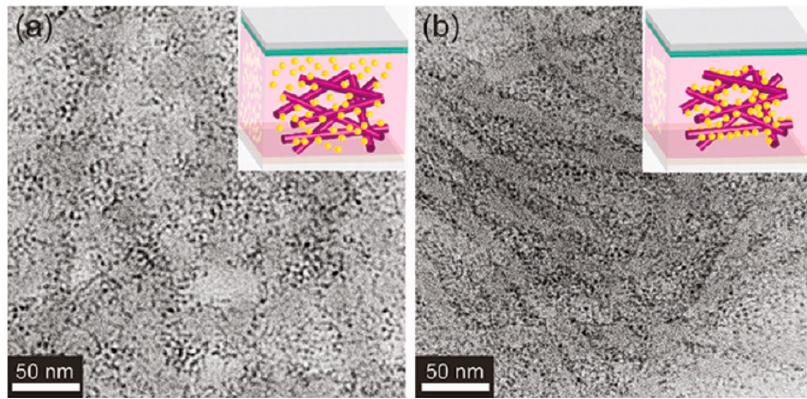
Figure 16. TEM images of P3HT/CdS QD hybrid films synthesized ( a ) without grafting and ( b ) using grafting process by solvent exchange. The inset images are schematic representations of each; CdS QDs are yellow spheres and P3HT NWs are purple lines. Reprinted with permission from [80]. Copyright 2011 American Chemical Society.